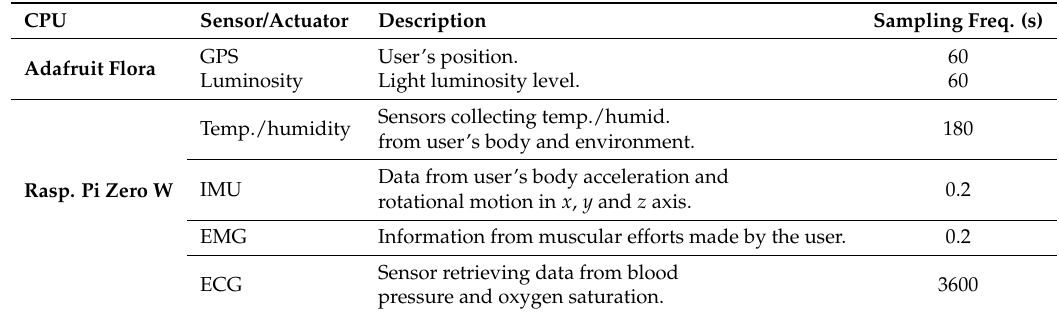
Table 4. List of platforms (CPUs), sensors and sampling frequency used in the wearable prototype for mining environments.